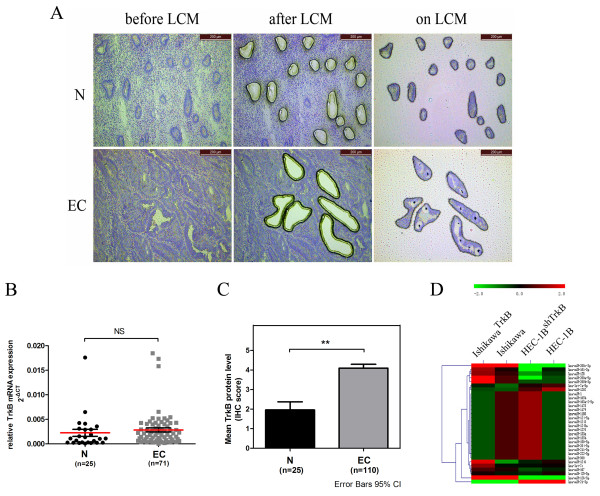
TrkB overexpression is associated with global changes in miRNA expression in endometrial cancer cells. (A) Laser capture microdissection (LCM) of normal (N) endometrial cells and endometrial cancer (EC) cells. 100×. (B) Quantitative reverse transcription polymerase chain reaction (qRT-PCR) of TrkB in endometrial cancer specimens (n = 71) and normal tissues (n = 25). TrkB expression was normalized against β-actin. Data are presented as individual samples with the line indicating the mean +/− SD. NS, P > 0.05. (C) Immunostaining scores of TrkB in normal endometrium (n = 25) and endometrial cancer specimens (n = 110). Data are presented as mean +/− SD. **, P < 0.01. (D) MicroRNA array analysis of miRNA expression in endometrial cancer cells. Hierarchical clustering of the expression values for 1347 mature miRNAs of IshikawaTrkB versus Ishikawa cells and HEC-1BshTrkB versus HEC-1B cells.